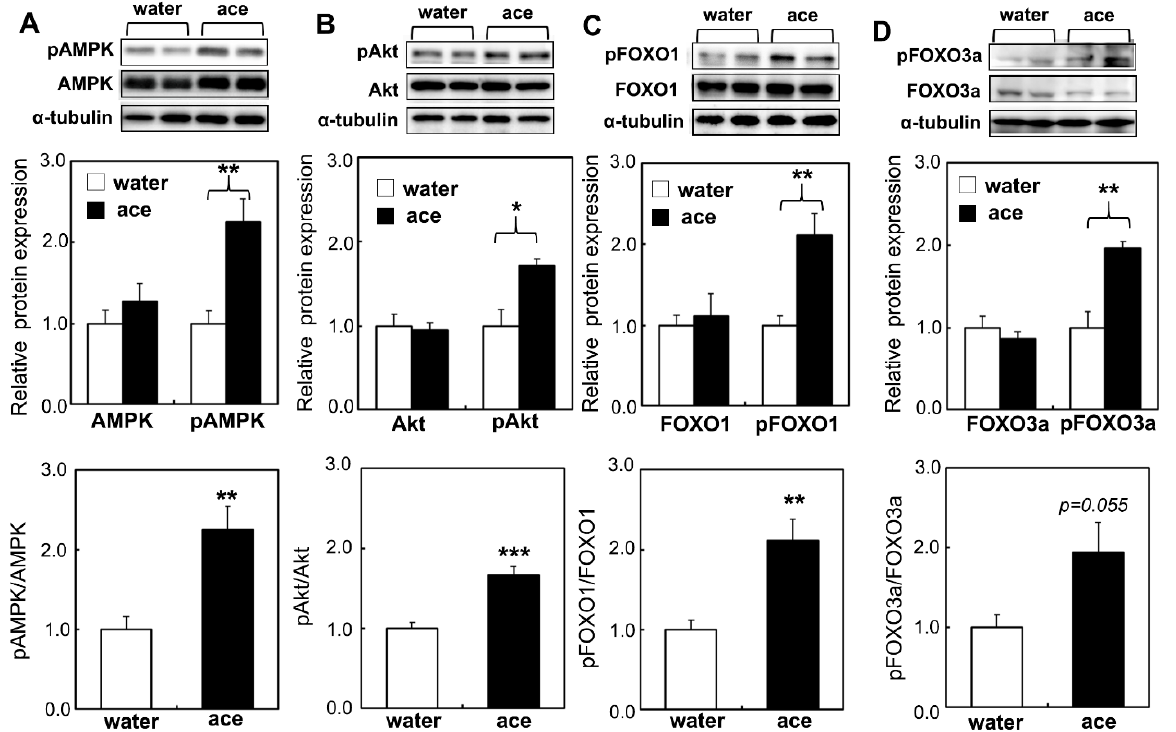
Figure 9. Long-term supplementation of acetic acid increases the phosphorylation of AMP-activated protein kinase (AMPK), Akt, forkhead box protein O (FOXO)1, and FOXO3a. AMPK and pAMPK ( A ), Akt and pAkt ( B ), FOXO1 and pFOXO1 ( C ), FOXO3a and pFOXO3a ( D ), and α -tubulin were analyzed in the soleus muscle of water and acetic acid groups. They were analyzed by Western blotting, as described in the Materials and Methods Section. Values represent means ± SE for 4–5 rats. * p < 0.05, ** p < 0.01, statistically significant versus the value of water group. Results were analyzed with Student’s t -test.